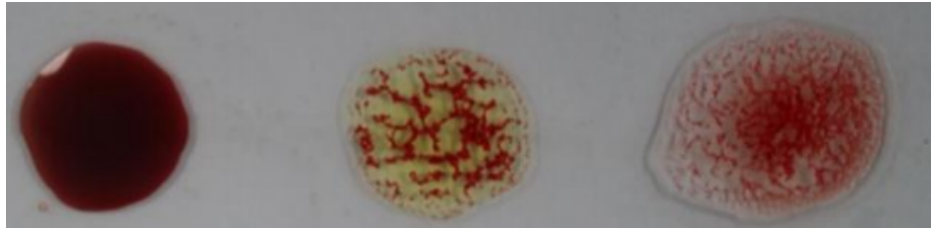
Figure 15. An example of an input